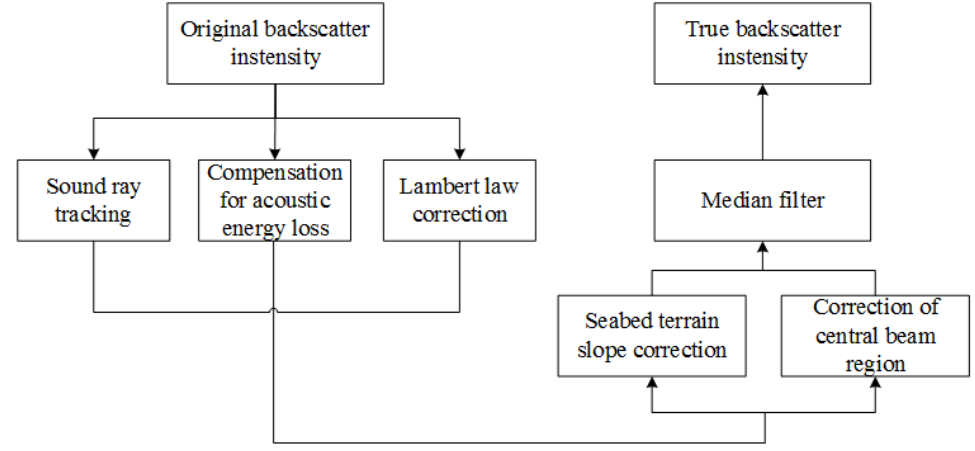
Figure 2. Fine processing flowchart of deep-sea multibeam backscatter intensity data.